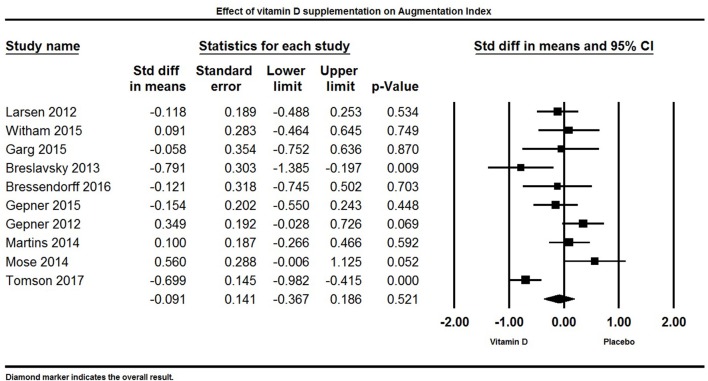
Forest plot detailing standardized mean difference for the impact of vitamin D on augmentation index.